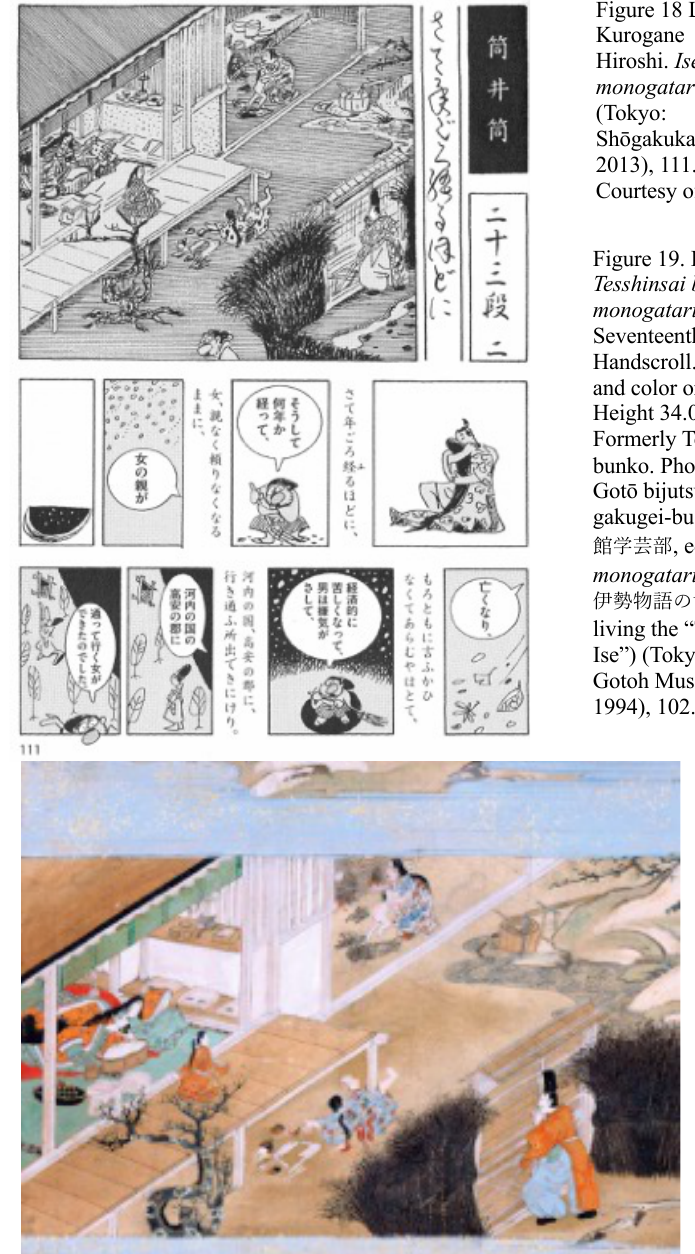
Figure 18 Left. Hiroshi. Ise